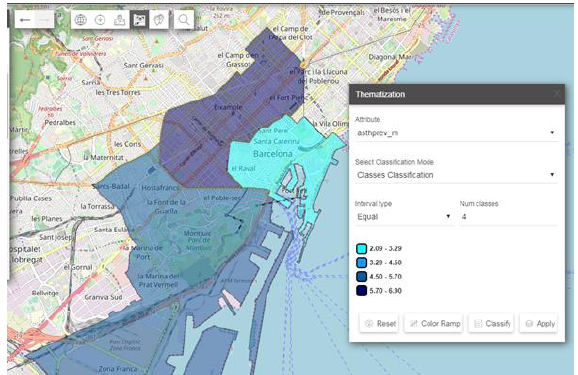
Figure 13. Thematization widget (by